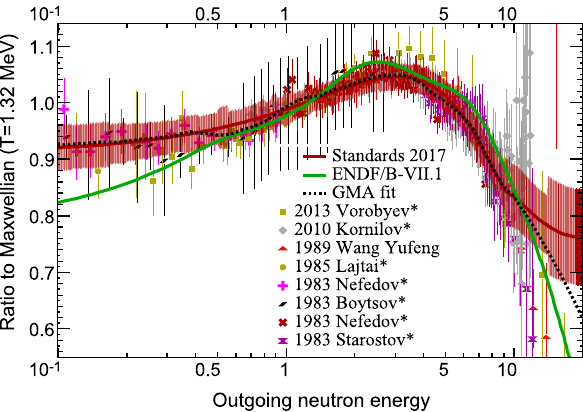
Fig. 5. 235 U( n th , f ) PFNS experiments are compared with the Standards 2017 evaluation (bold red), the GMA fi t (dashed black), and the ENDF/B-VII.1 evaluation (bold green). Above 9MeV the Standards 2017 evaluation was fi tted to the 90 Zr( n ,2 n ) spectrum average cross